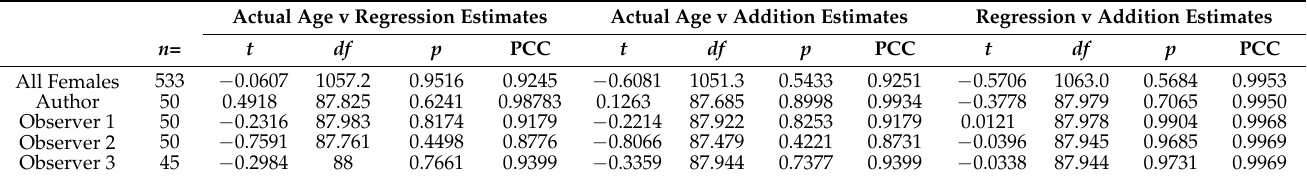
Table 10. T-test and Pearson coefficient analyses comparing estimates derived by regression versus simple addition.